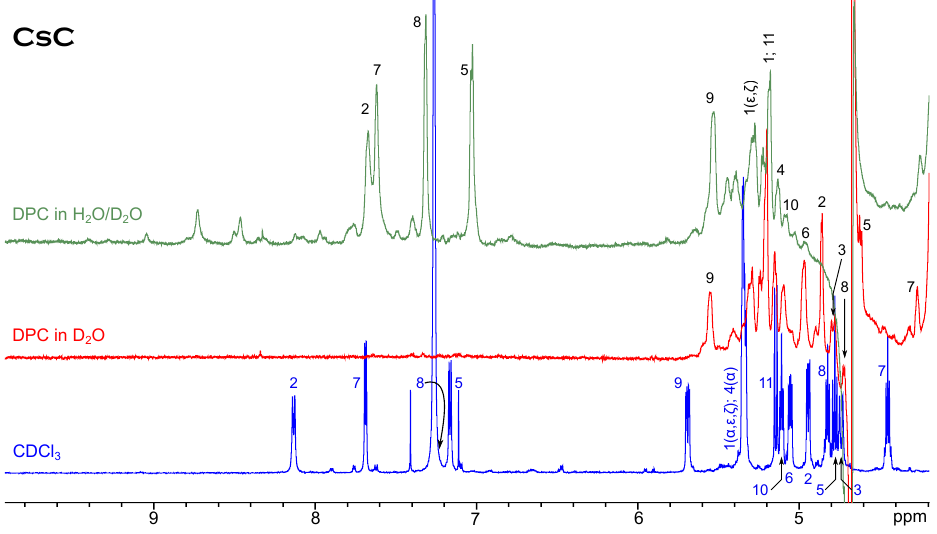
Figure 2. 1 H NMR spectrum of CsC in chloroform compared to spectra in micellar solution. Ths case of cyclosporin E is slightly different (Figure 3). Neither in the chloroform solution nor in the CsE/DPC micelle complex can minor conformers be observed. The tendency to the upfield shift of resonances of the alpha-protons is still present, but among amide resonances only Val5 moves far to the right-hand side of the spectrum, while Dal8 and especially Val11 show a remarkable down-field shift.